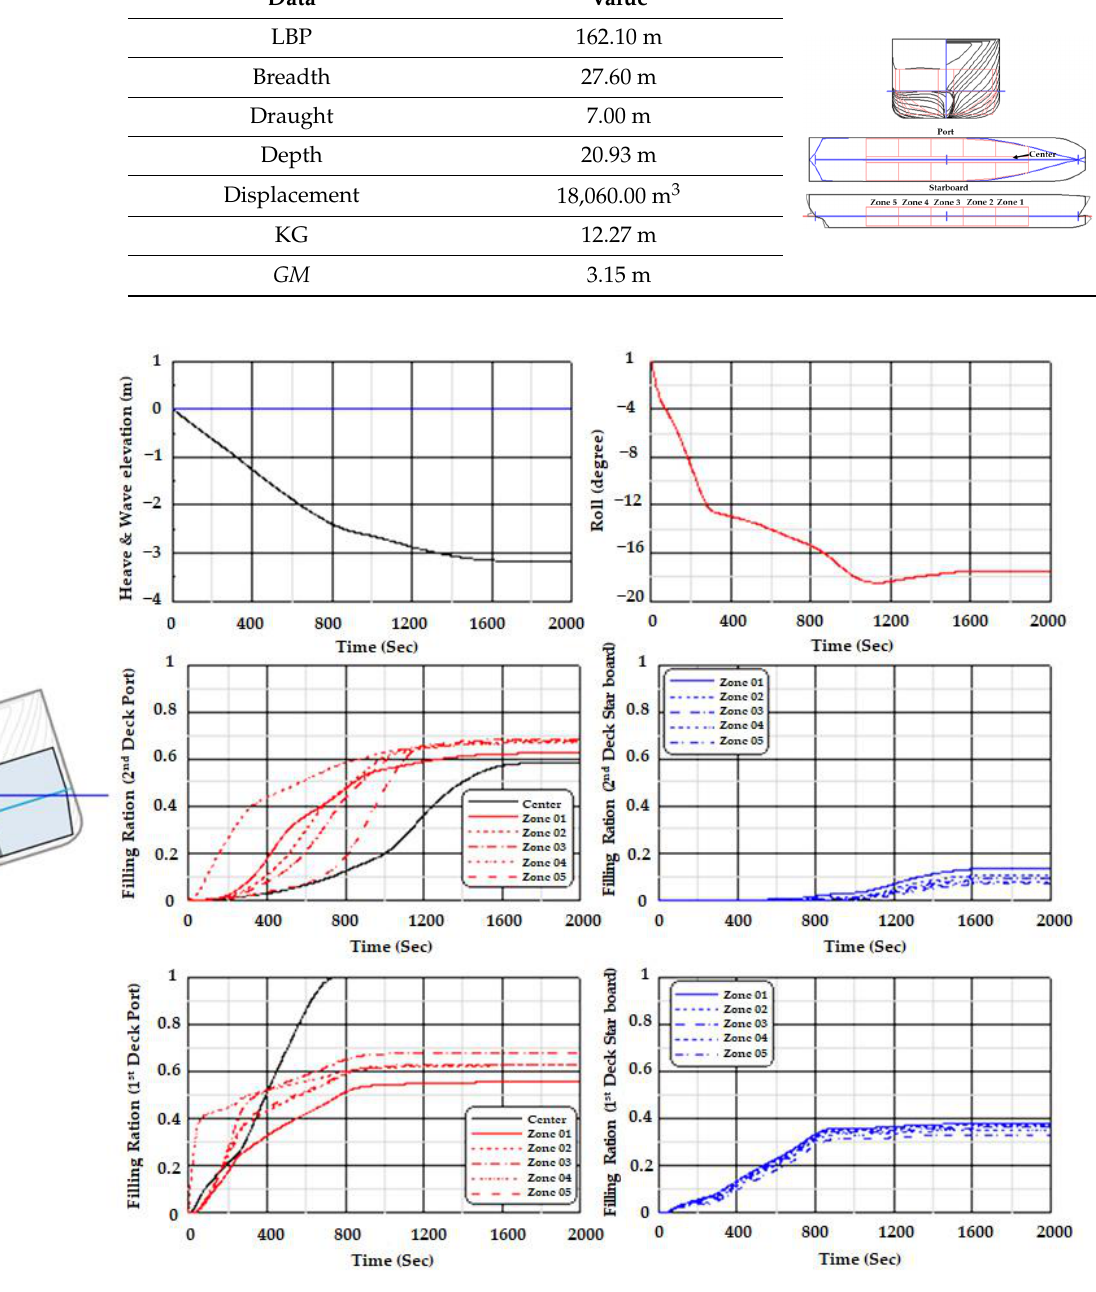
Table 2. Specifications of the example ship for flooding characteristic comparison.